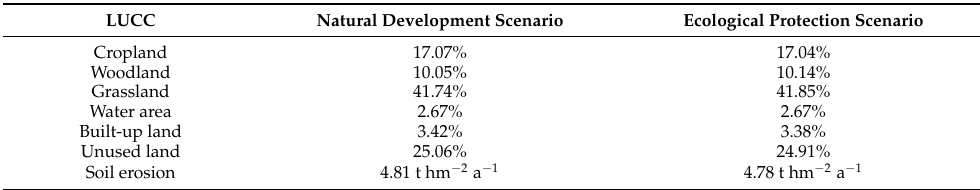
Table 7. Proportion of land-use area and soil erosion characteristics under different scenarios in the YRB in